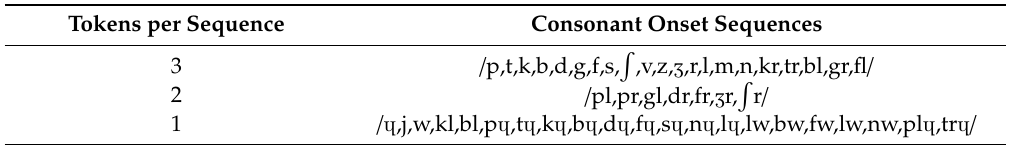
Table 1. Stimuli consonant onset